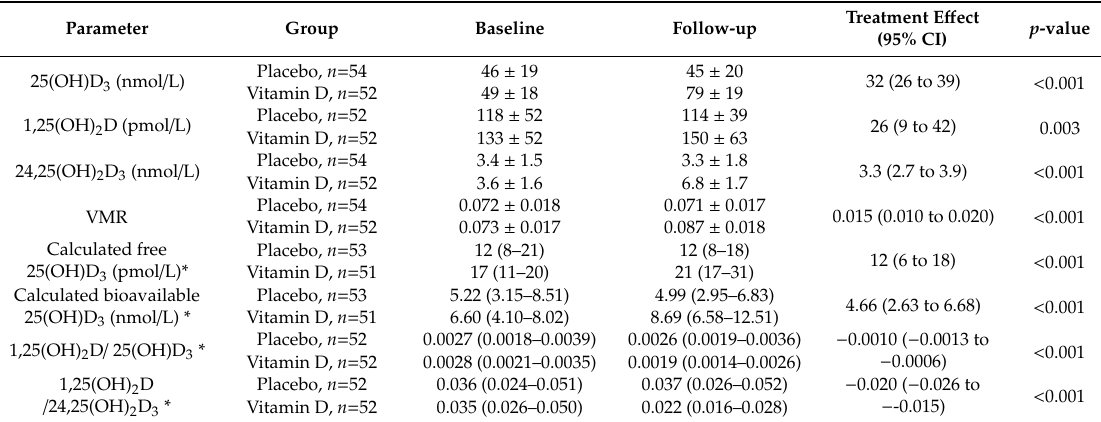
Table 2. Analysis of covariance (ANCOVA) analysis for the e ff ect of vitamin D or placebo treatment on vitamin-D-related